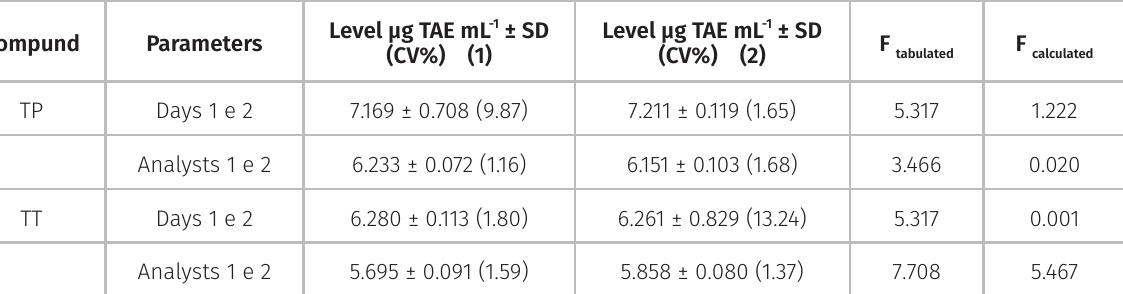
Table IV. Intermediate Precision. Compund F